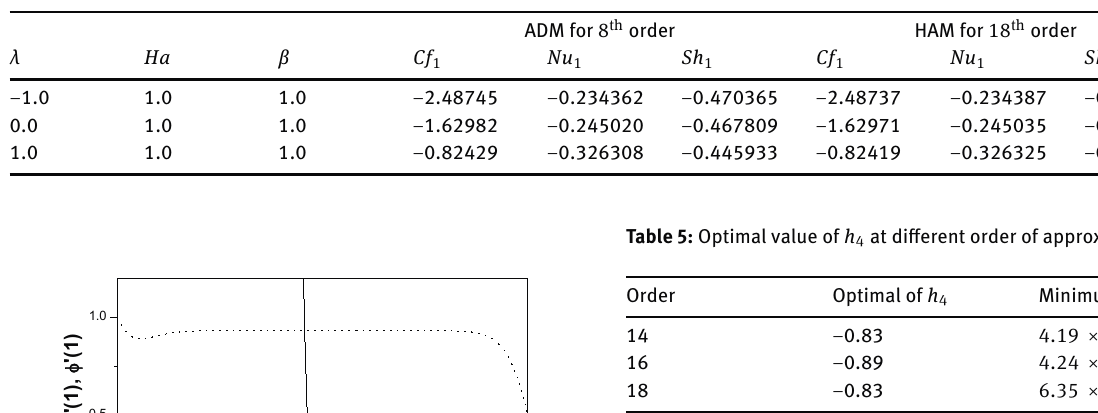
Table 1: Comparison of Cf 1 , Nu 1 , and Sh 1 between ADM and HAM when B = 1.0, R = 1.0, A = 1.0, Pr = 0.71, B i = 2.0, Sc = 0.22, B h = 2.0, Sr = 0.3, Br = 0.5 .